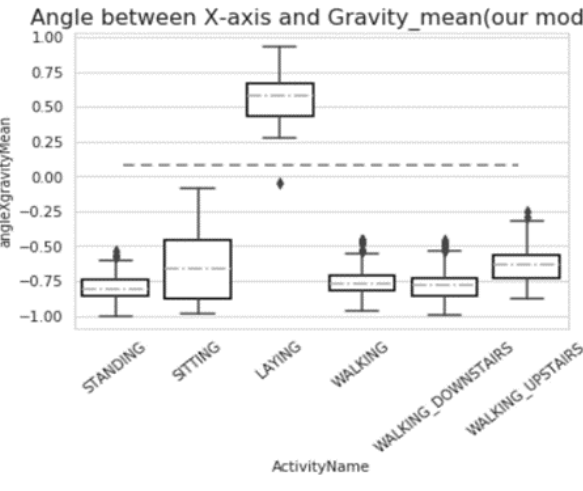
Figure 8. Box-plot of angle between the x -axis and Gravity mean (after preprocessing).